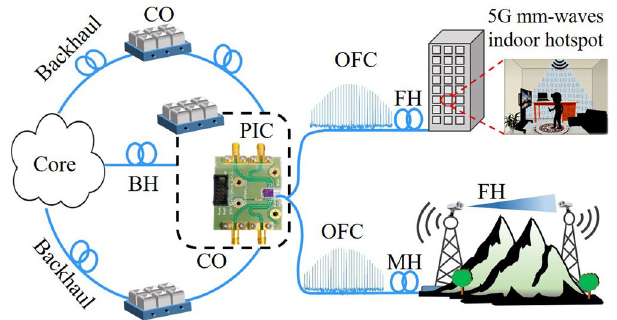
Figure 1. The proposed 5G NR system based on an integrated OFC. BH backhaul, CO central-office, FH fronthaul, MH midhaul, FSO free-space optics, OFC optical frequency comb, PIC photonic integrated circuit.